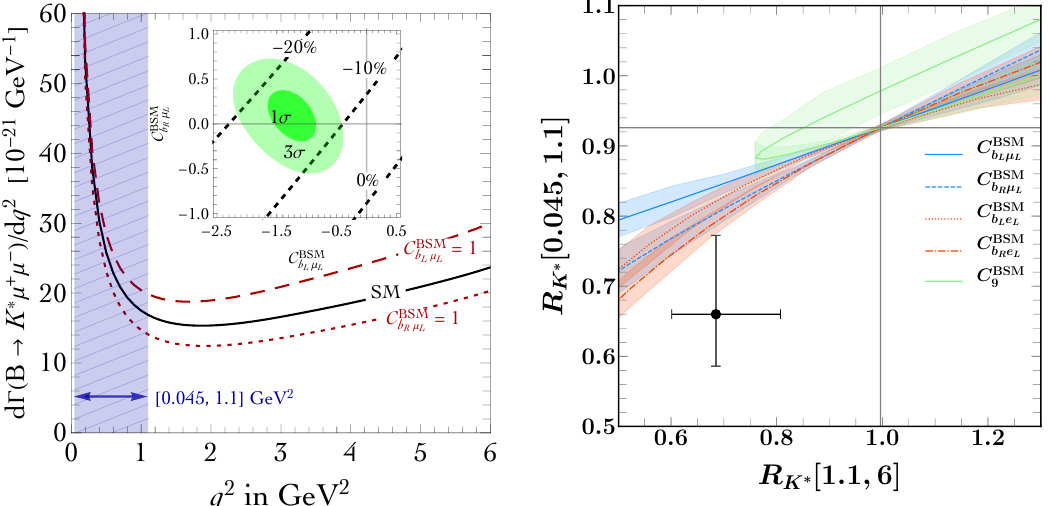
Figure 2 . Left: R K (cid:3) as function of q 2 , the invariant mass of the ‘ + ‘ (cid:0) pair, for the SM and for two speci(cid:12)c values of the new-physics coe(cid:14)cients. The inset shows iso-contours of deviation from = 1 in the [0 : 045 ; 1 : 1] GeV 2 bin as a function of new-physics coe(cid:14)cients, compared to their R (cid:3) K experimentally favoured values. Right: correlation between R K (cid:3) measured in the [1 : 1 ; 6] GeV 2 bin (horizontal axis) and [0 : 045 ; 1 : 1] GeV 2 bin (vertical axis) of q 2 : a sizeable new physics e(cid:11)ect can be present in the low-energy bin. The numerical values of q 2 are given in GeV 2 .